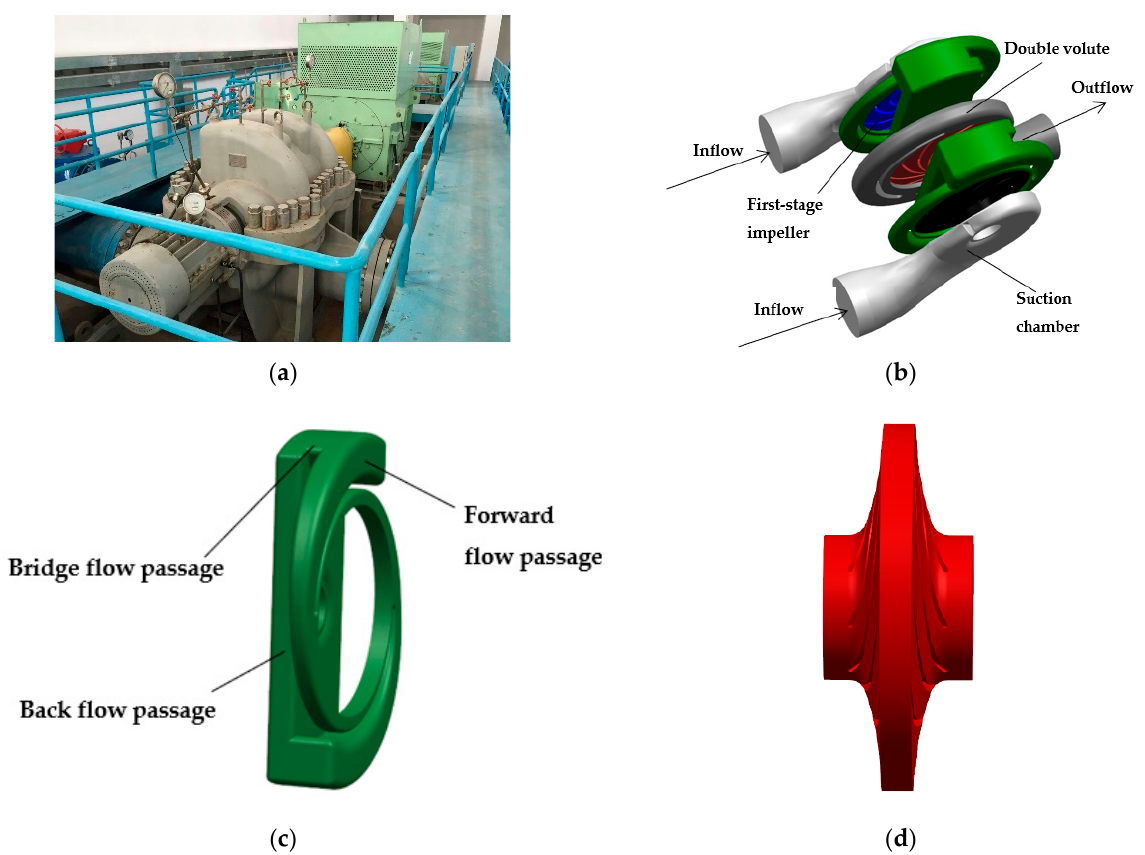
Figure 1. Three-dimensional model of the pump, which includes ( a ) Physical drawing, ( b ) assembly drawing, ( c ) inter-stage flow channel, and ( d ) second-stage impeller.